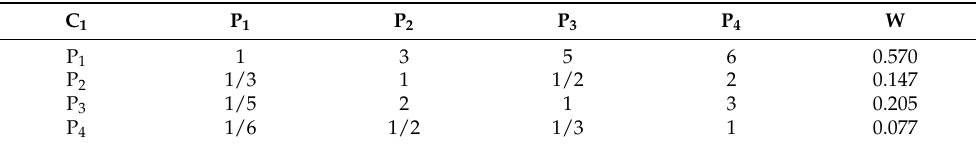
Table 7. The results of matrix and its consistency test between Constraint layer (C 1 ). and Standard layer (P 1 –P 4